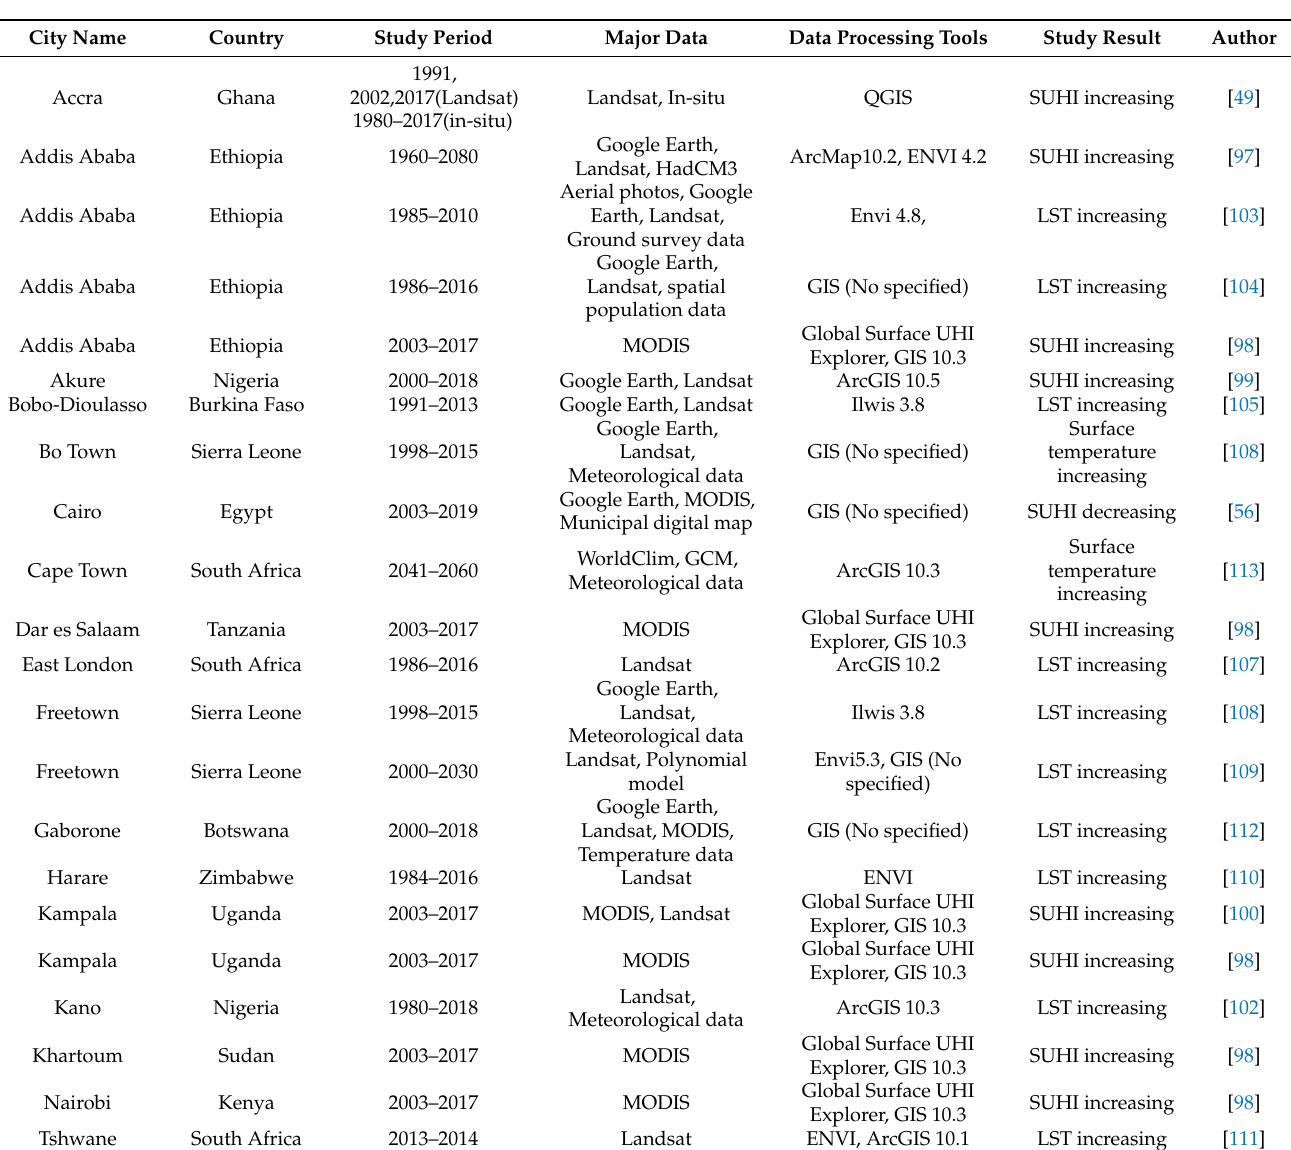
Table 2. City-scale studies about urbanisation and climate change on urban thermal environment